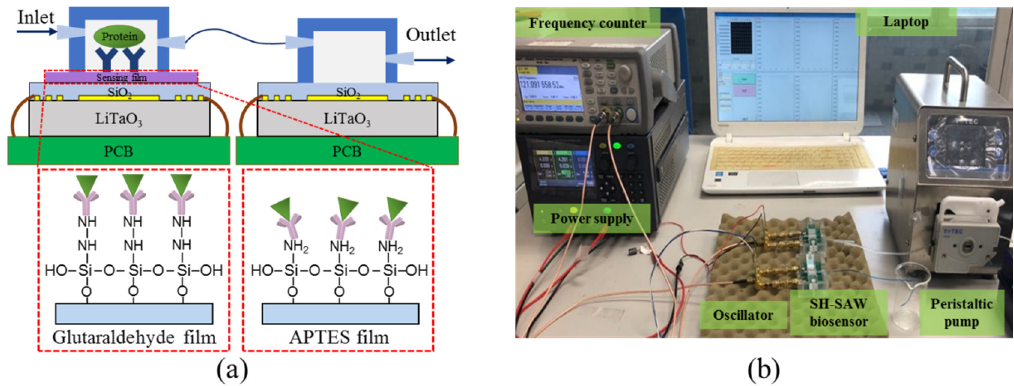
Figure 3. ( a ) Configurations of the dual SH ‐ SAW biosensors and the illustration of EGF antigen binding on these two films. ( b ) Experiment apparatus.